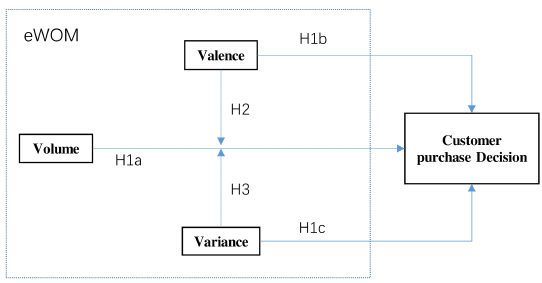
Figure 1. Conceptual